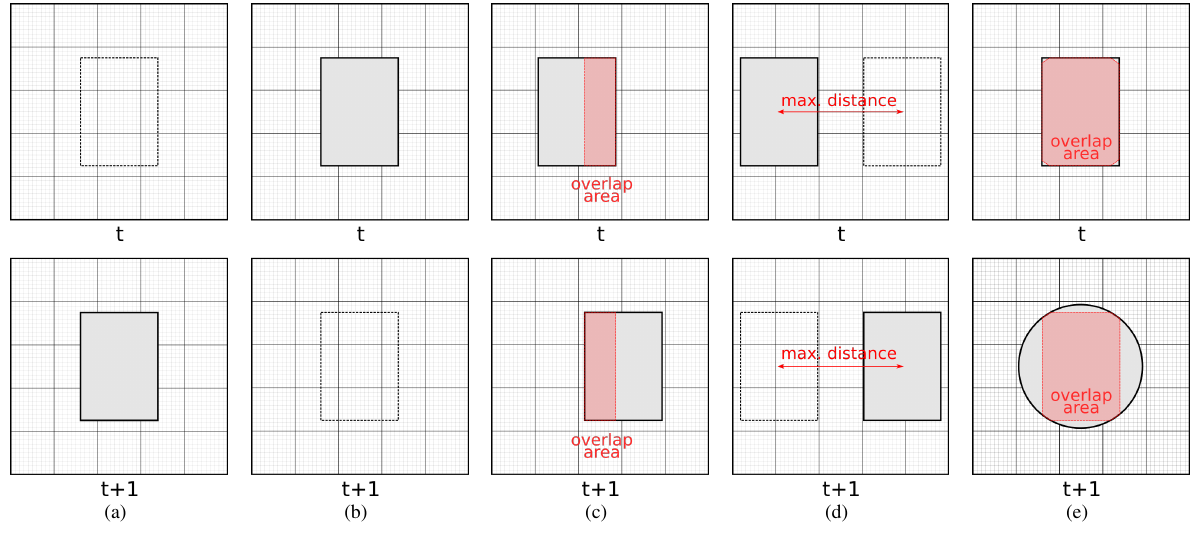
Figure 2. The change detection classes, (a) appeared , (b) disappeared , (c) partially moved , (d) fully moved and (e) deformed .